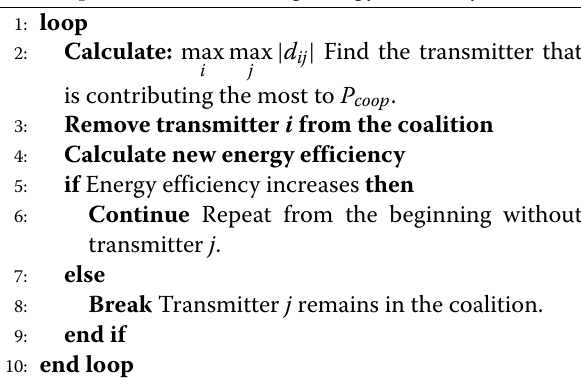
returned to the last step. This greedy transmitter selection operation is explained in Algorithm 3.